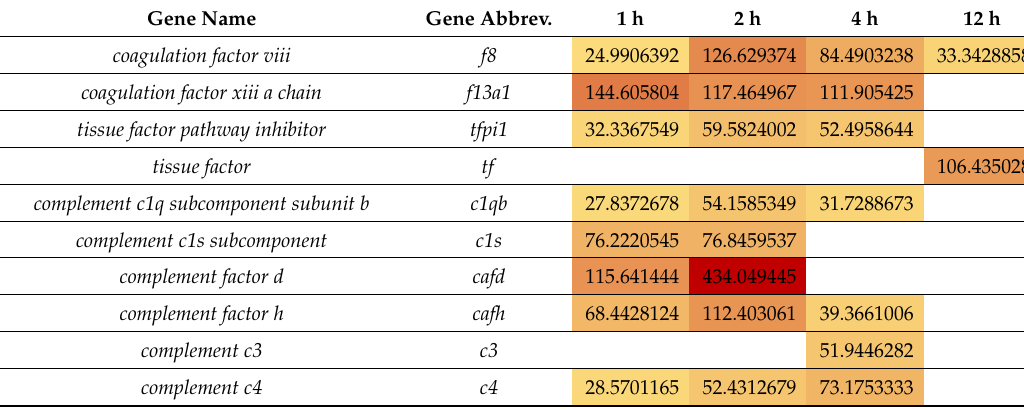
Table 9. Heat map showing a group of DE genes in turbot peritoneal cells at 1, 2, 4 and 12 hpi, including complement and coagulation related genes. Results are expressed as mean expression ratios of groups 1, 2 and 4 hpi vs. 0 h, or 12 hpi vs. PBS. There were no DE genes at 48 hpi. Red indicates increased gene expression levels; green indicates decreased